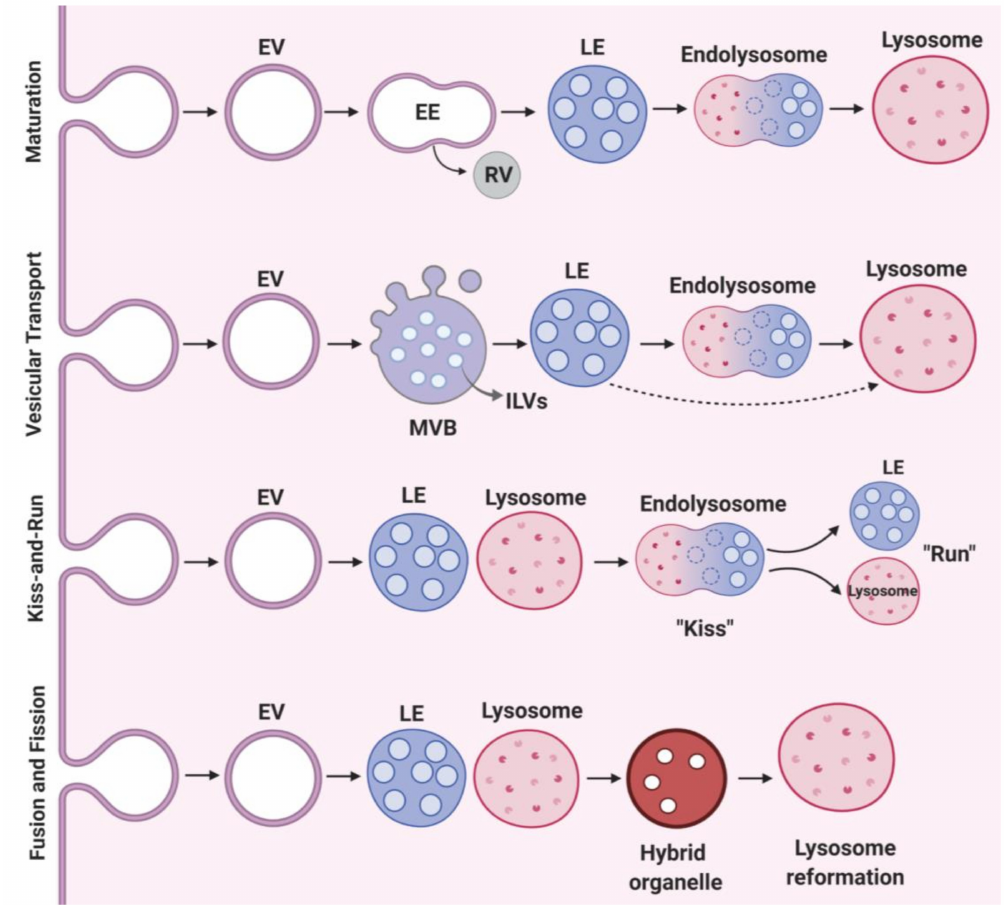
Figure 1. Molecular events in lysosome biogenesis. Maturation; this model of lysosome biogenesis describes the formation of EVs (endocytic vesicles) from the plasma membrane and their progressive maturation to late endosomes and subsequently to lysosomes. The cargo targeted for recycling is carried by the TGN derived RVs (recycling vesicles), whereas cargo required for lysosomal